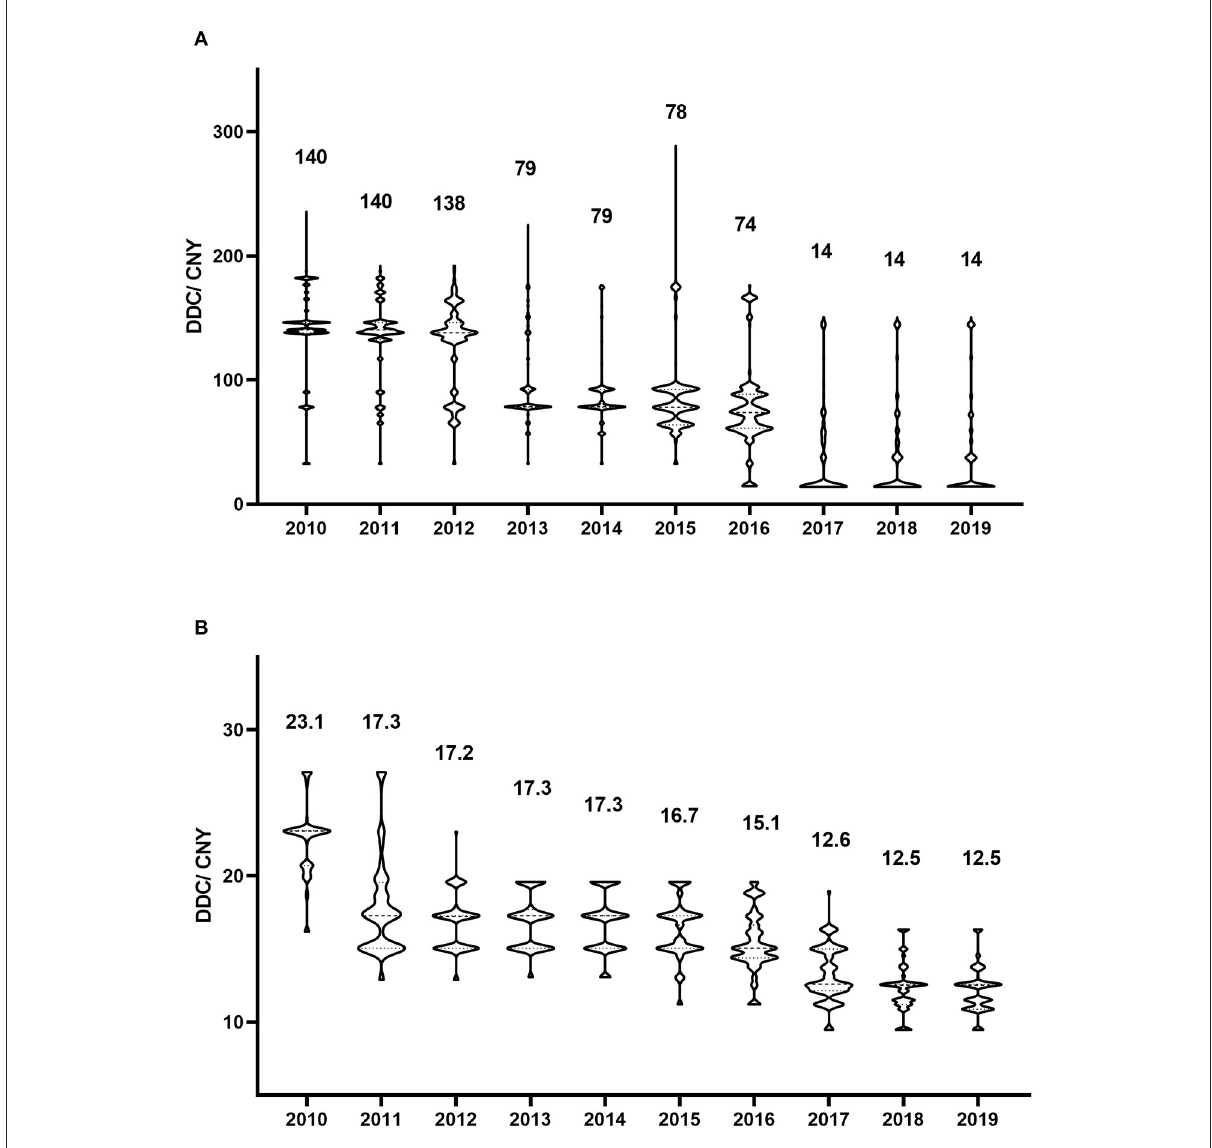
FIGURE3 Defined daily cost of antivirals in each year. (A) Valaciclovir; (B) Famciclovir. The numbers represent the median defined daily cost for each